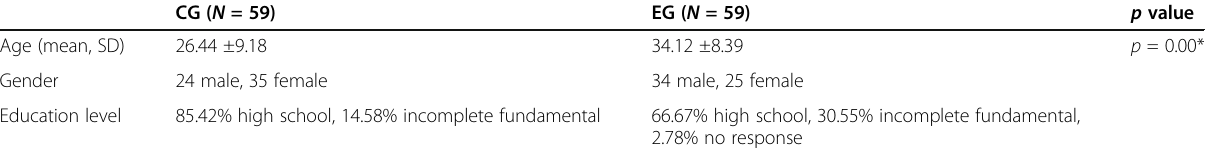
Table 2 Characterization of the EG and CG in terms of age, gender, and formal education CG ( N =